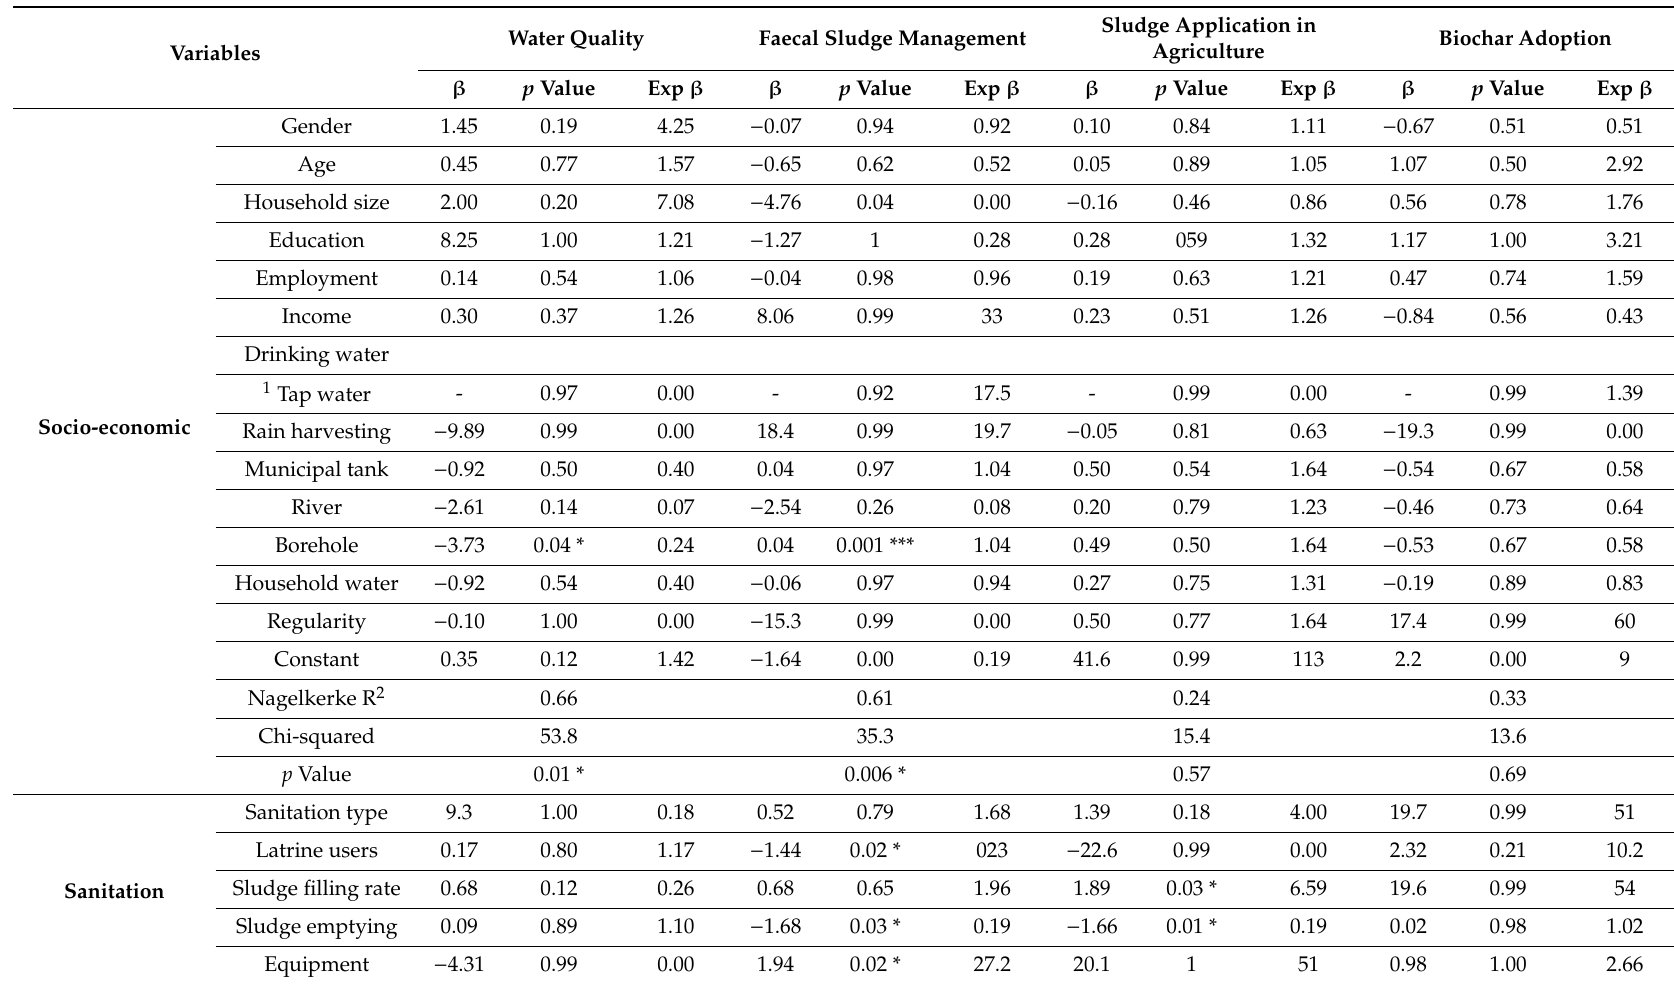
Table 5. Binary logistic regression of factors influencing water quality, faecal sludge management, sludge application in agriculture and adoption of biochar within a